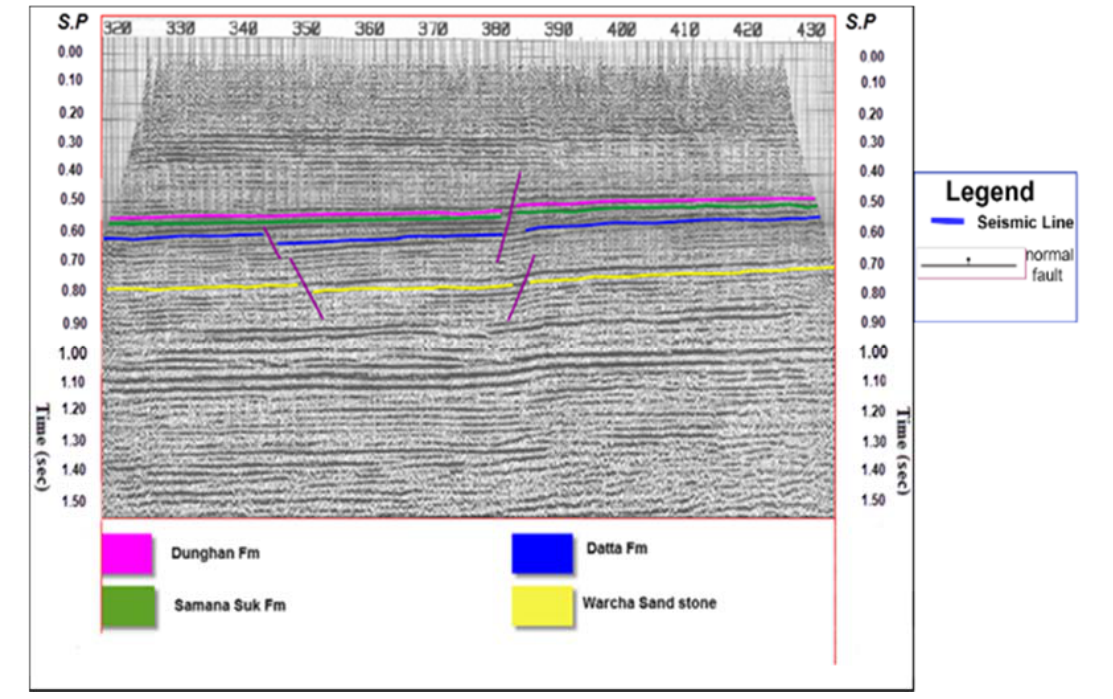
Figure 5. Marked seismic horizons of 875-KBR-229 line.